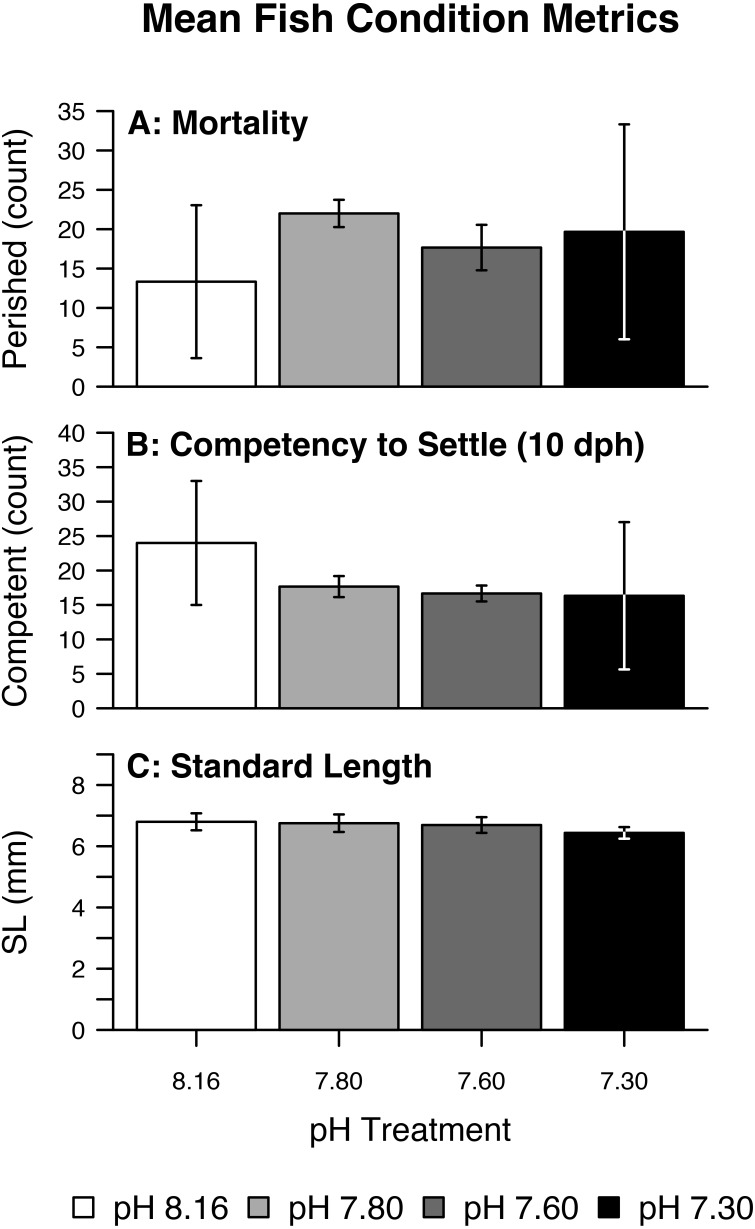
Mean fish condition metrics.Summary of raw (fish-level) fish condition data by pH/pCO2 treatment (legend) including (A) Mortality, (B) Competency to Settle at 10 days post-hatch (dph), (C) Standard Length. Bars represent combined means. Lines represent one (pooled) standard deviation.